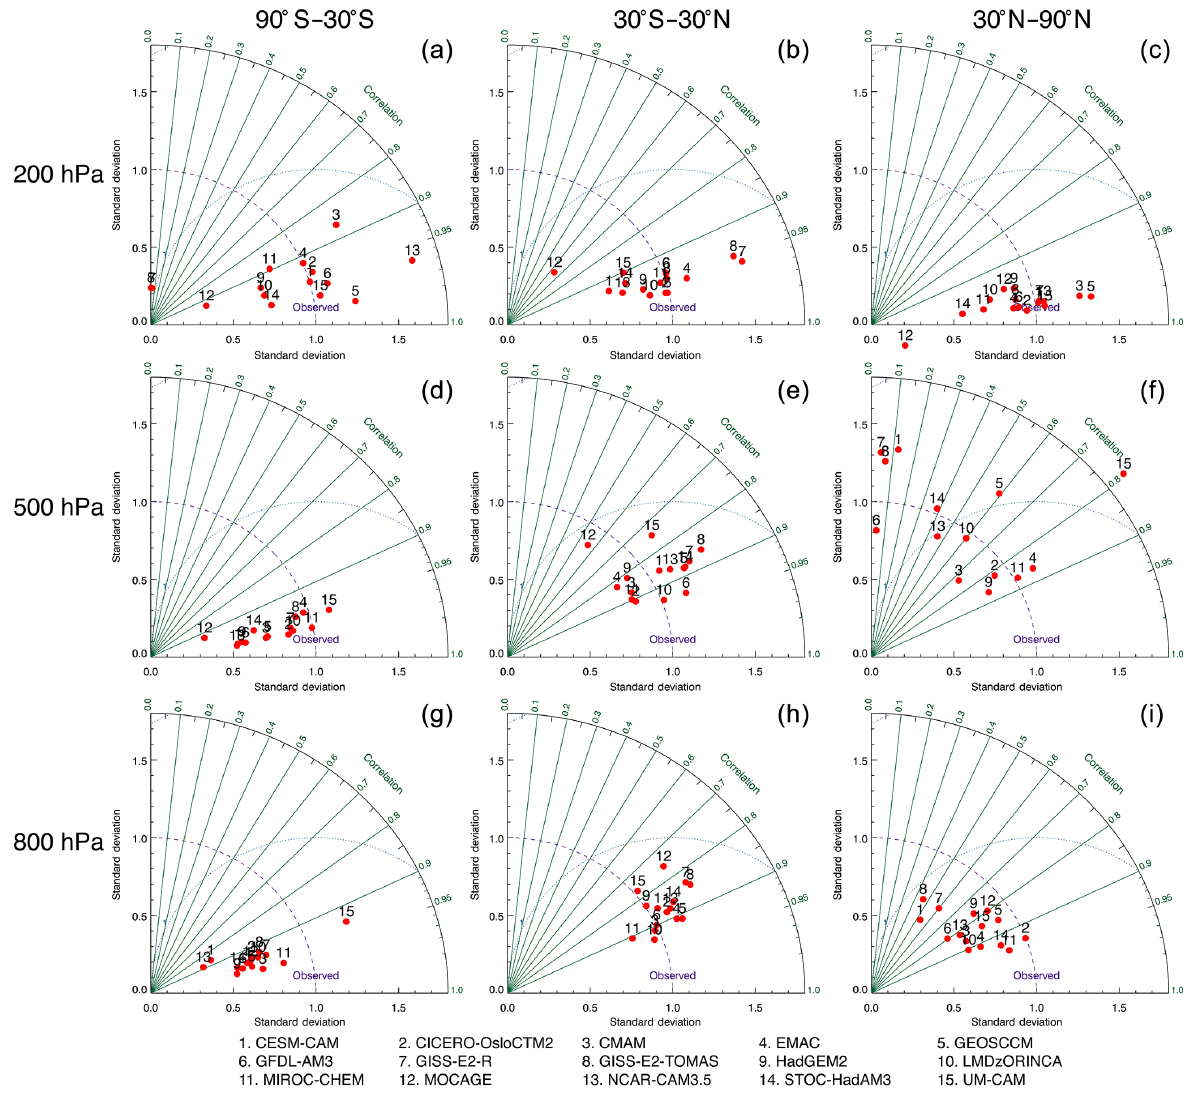
Figure 4. Taylor diagrams showing standard deviation normalized with respect to that of the reanalysis ( x axis) and spatial correlation coefficient ( y axis) for the comparison of annual mean ozone concentrations between ACCMIP models and reanalysis for SH extratropics (90–30 ◦ S, a, d, g ), tropics and subtropics (30 ◦ S–30 ◦ N, b, e, h ), and NH extratropics (30–90 ◦ N, c, f, i ) at 200hPa (a–c) , 500hPa (d–f) , and 800hPa (g–i)